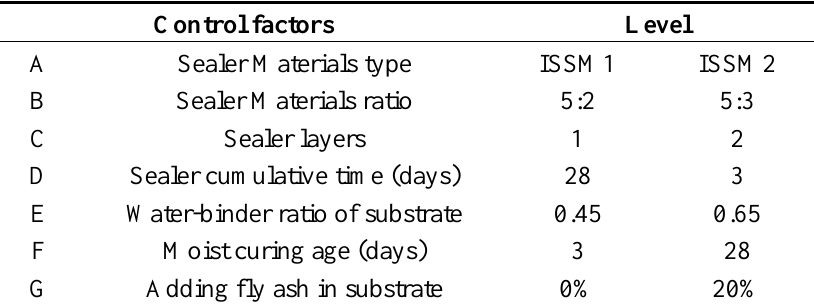
Table 3. Designation of control factors and factor levels.